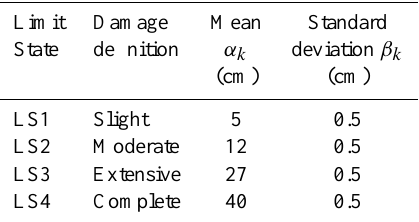
Table 3. Mean and standard deviation parameters computed for the four limit states (LSk) proposed in this analysis, and used to build the fragility curves.